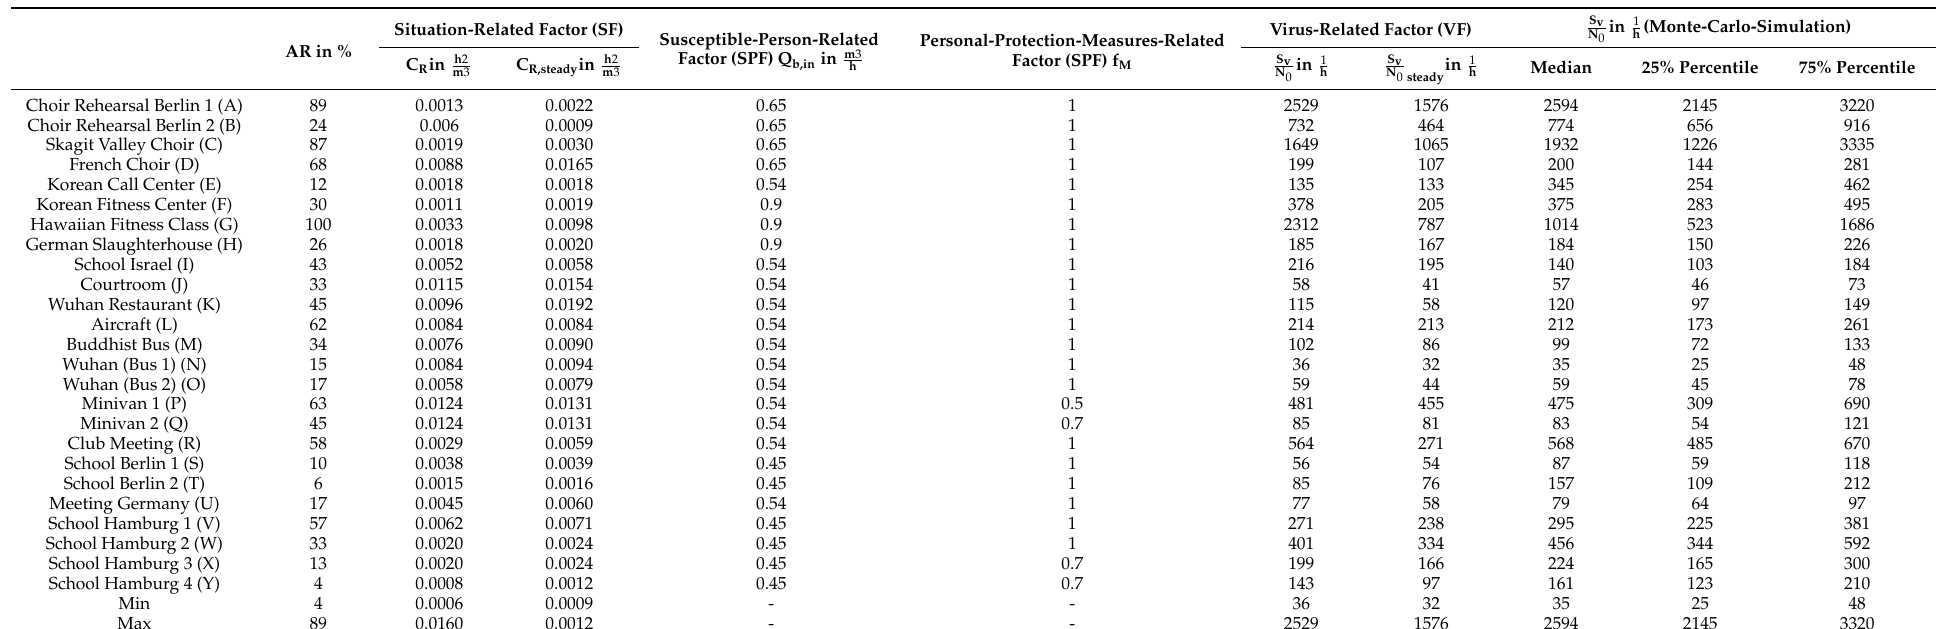
Table 1. Results for the different factors for the investigated